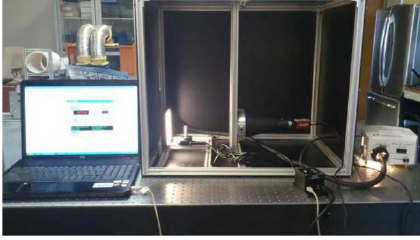
Figure 7. Shape from Contour setup.